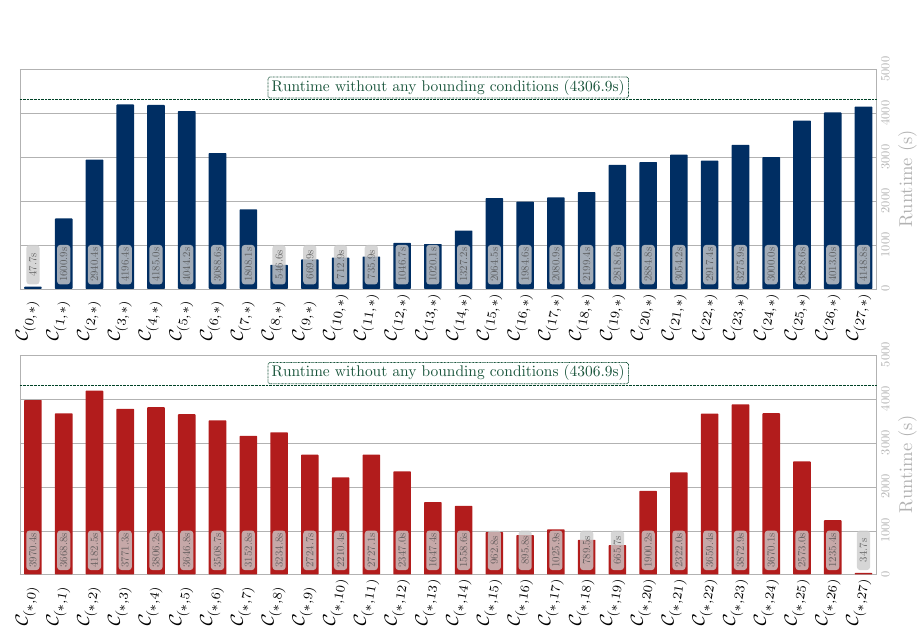
and C for GIFT-64 ( r 1 , ∗ ) ( ∗ ,r 2 )